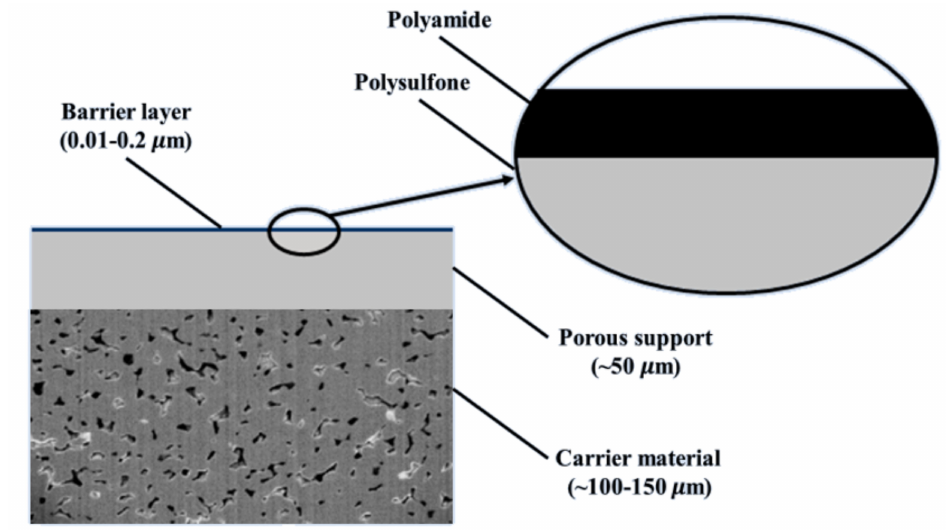
Figure 3. Thin-film composite membrane